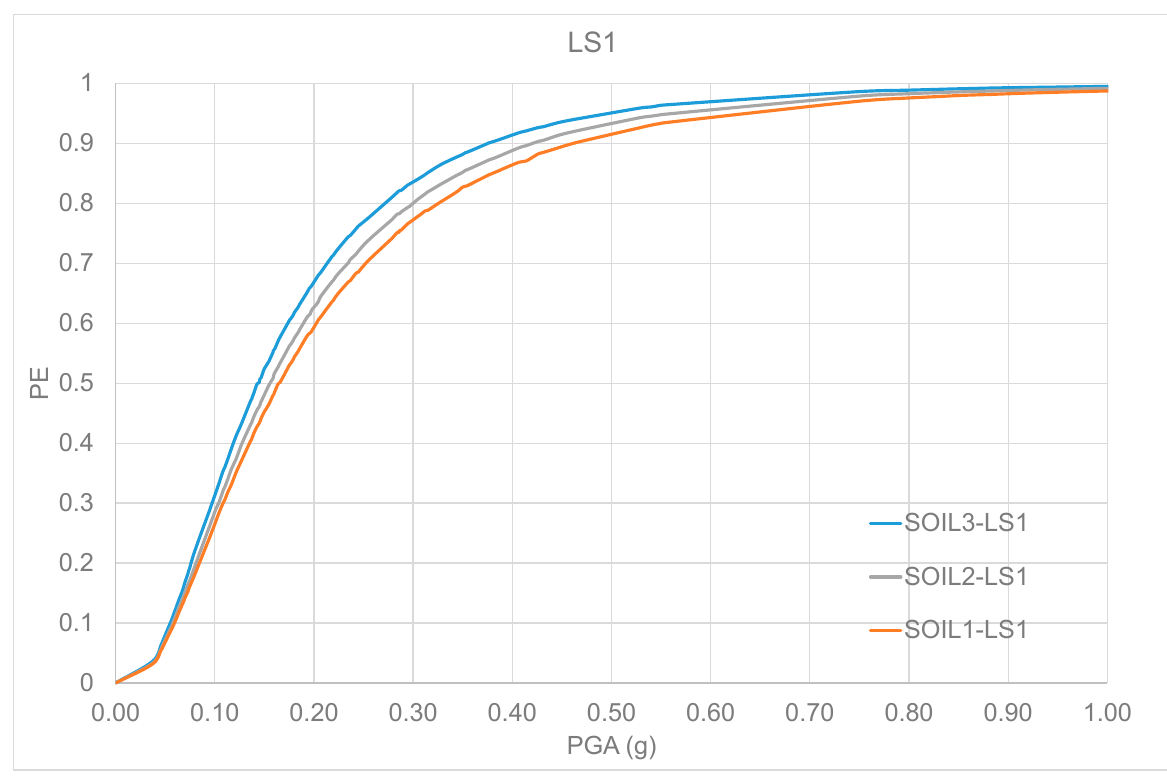
Figure 9. Fragility Curves: comparison LS1.